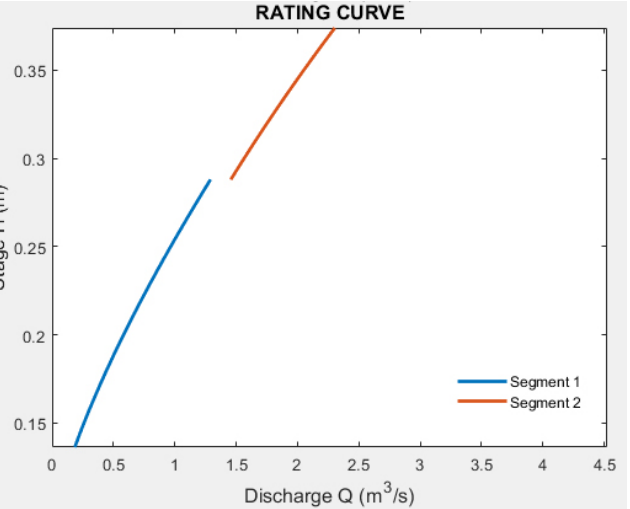
Figure 10. Magnification of previous figure showing the discontinuity that produces two different discharges at the same stage